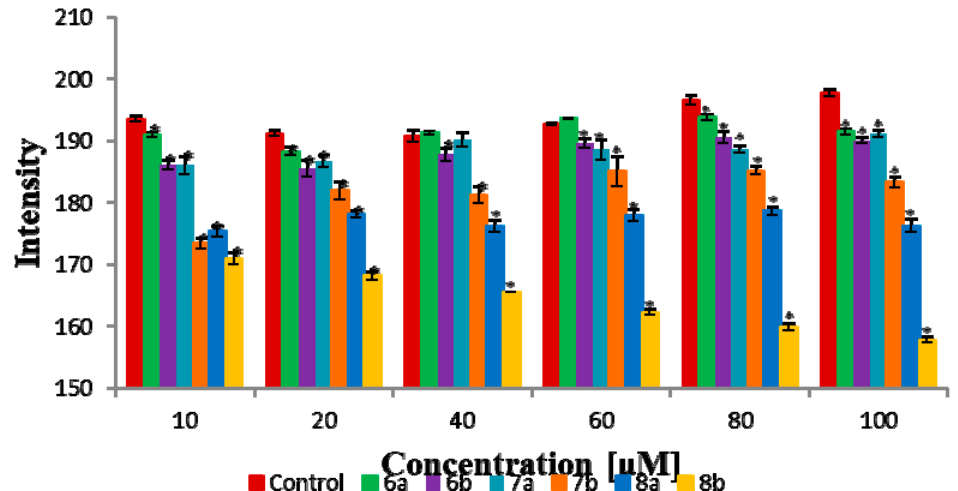
Figure 4. Changes of intensity of MC540 probe measured at 585 nm for RBCMs (control) and RBCMs with addition of tested compounds. The measurement was carried out at 37 °C. Values are mean ± SEM. Means labeled with asterisk (*) are significantly ( p ˂ 0.05) different from control.